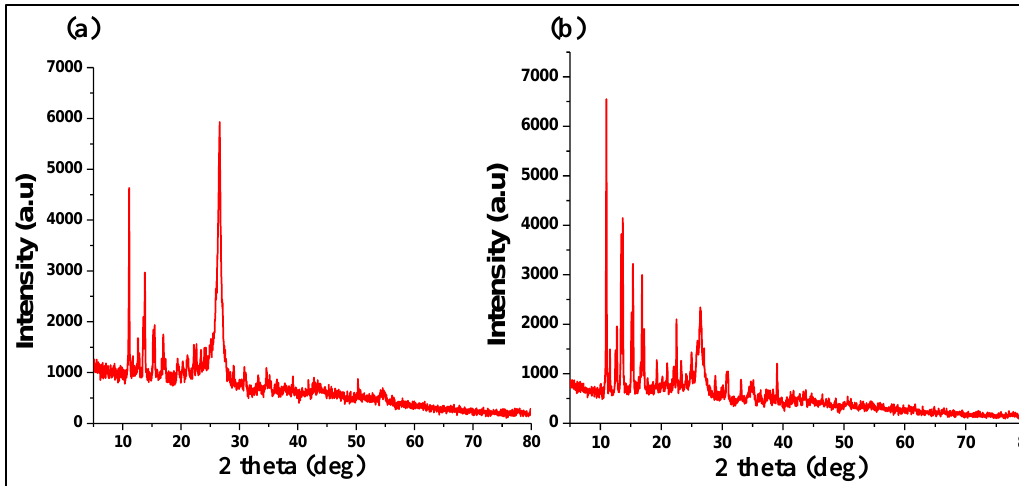
Figure 3. Simulated powder X-ray diffraction patterns of ( a ) GO-NCD- 1 and ( b ) GO-NCD- 2. The SEM images of GO displayed the sheet structure and the typical wrinkle structure, which could be due to the thermal fluctuations and applied stresses. SEM images of the loaded sheets showed irregular nanoparticle morphology in both the composites, therefore clearly showing the encapsulation of nanodrug candidates on the graphene oxide sheet. TEM images provided concrete evidence of the loading of the drug nanoparticles on the GO surface, with an average particle diameter of 17 ± 6.9 nm and 25 ± 6.5 nm in GO-NCD- 1 and GO-NCD- 2, respectively. The diameter size of nanoparticles was calculated by measuring the diameters of 16 nanoparticles of uniform size and spherical shape chosen randomly through TEM images for each nanocomposite (Table S1) [31]. Furthermore, EDS results showed the presence of Ru, N, C, O, and Cl in GO-NCD- 1 and Ru, N, C, O, Cl, and F in GO-NCD- 2, therefore providing evidence of the successful anchoring of the drug nanoparticles onto the carrier surface (Figures 4 – 6).